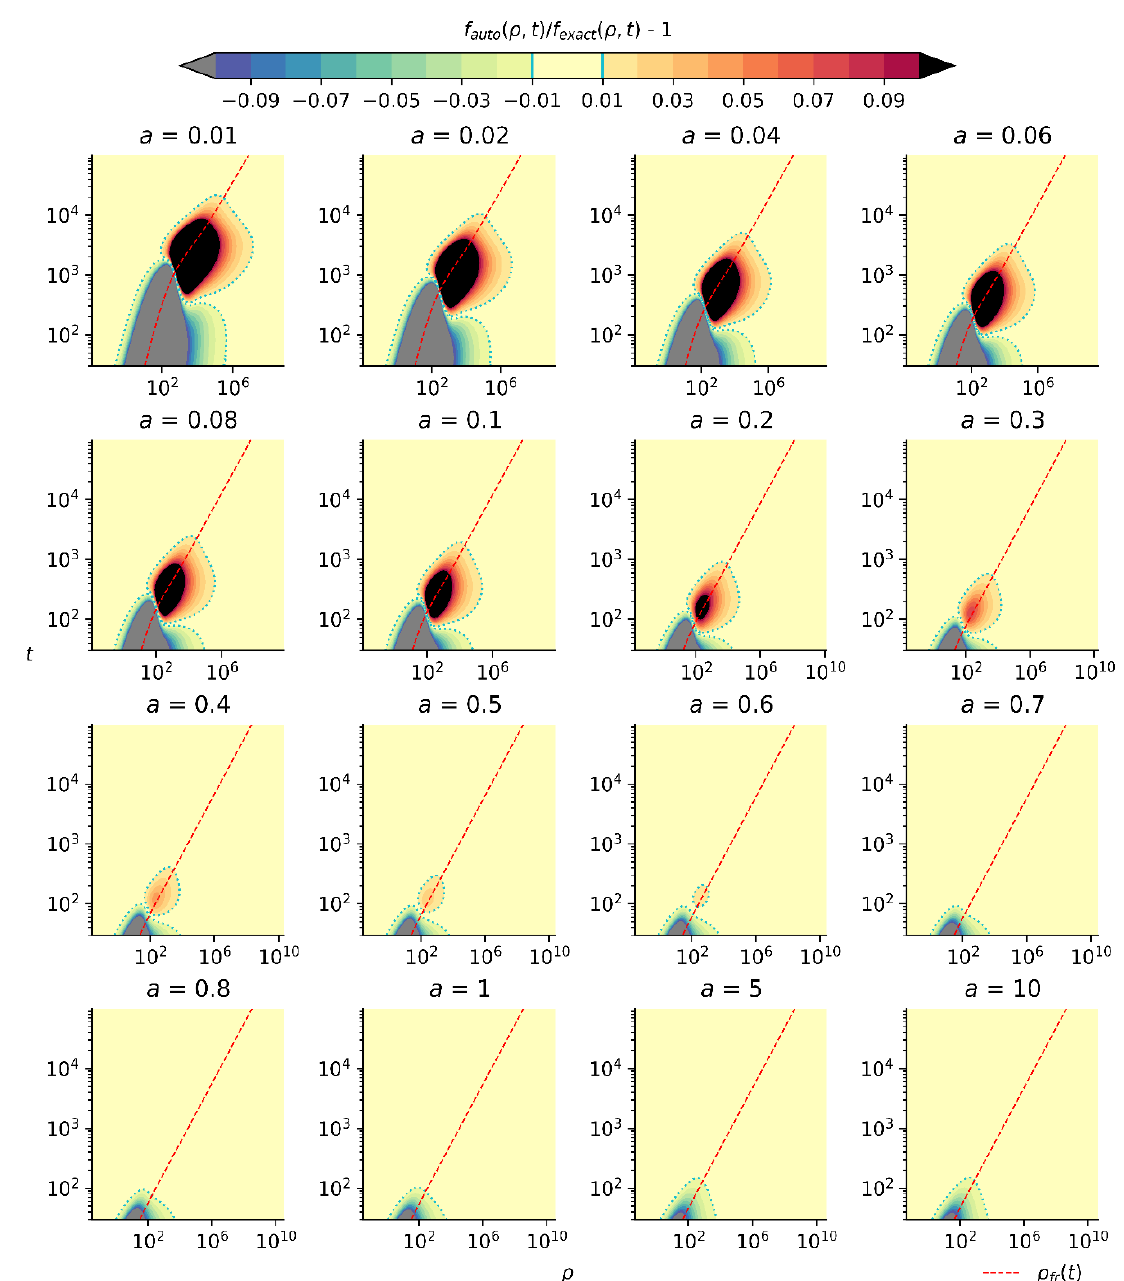
Figure 5. The same as in Figure 3, but for the propagation front ρ = ρ fr taken in the form of Equation (25).